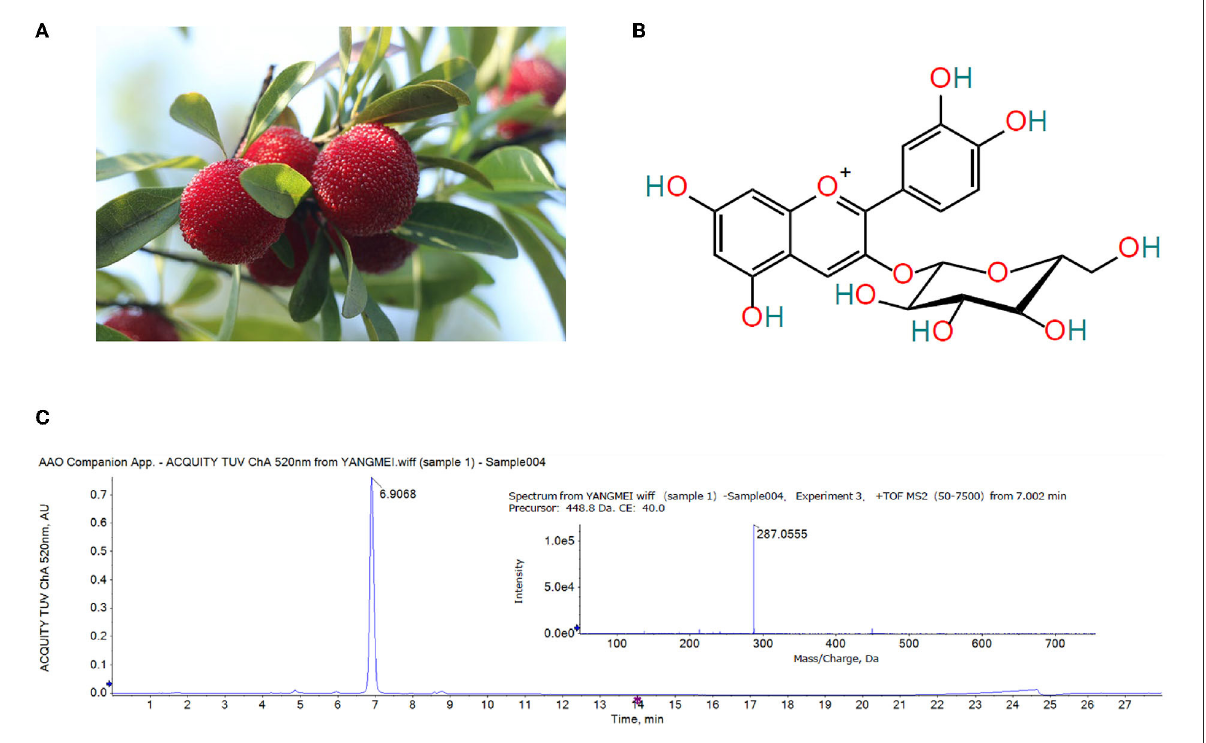
FIGURE1 (A) Ripe ‘Dongkui’ bayberry fruit (B) Structure of cyanidin-3- O -glucoside (C) UPLC chromatogram ( λ = 520nm) and MS/MS spectrum of the Chinese bayberry